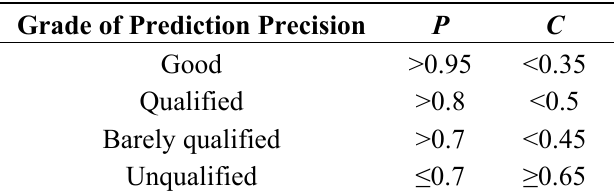
Table 3. Grades of prediction